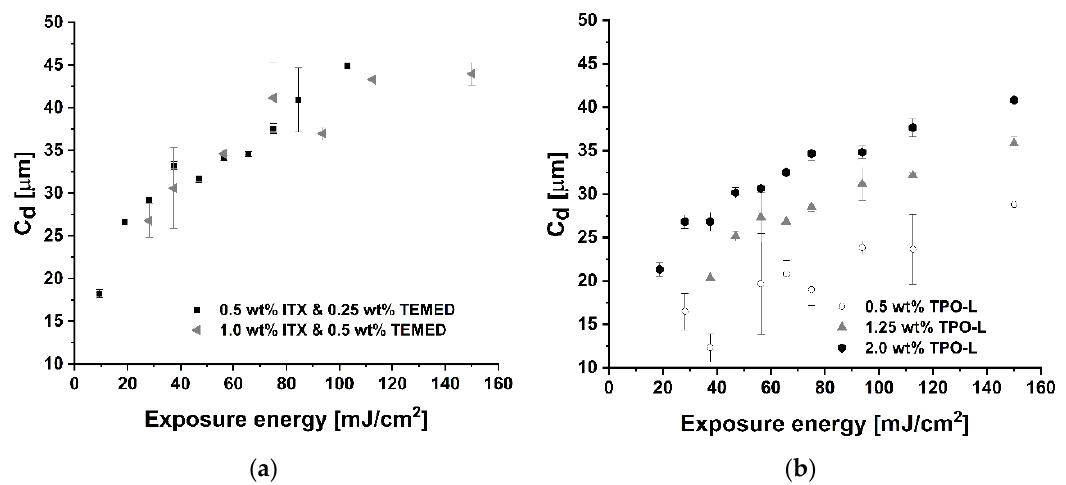
Figure 4. Cure depth in the function of exposure energy for slurries containing ( a ) ITX and TEMED, ( b ) TPO-L as a photoinitiator.